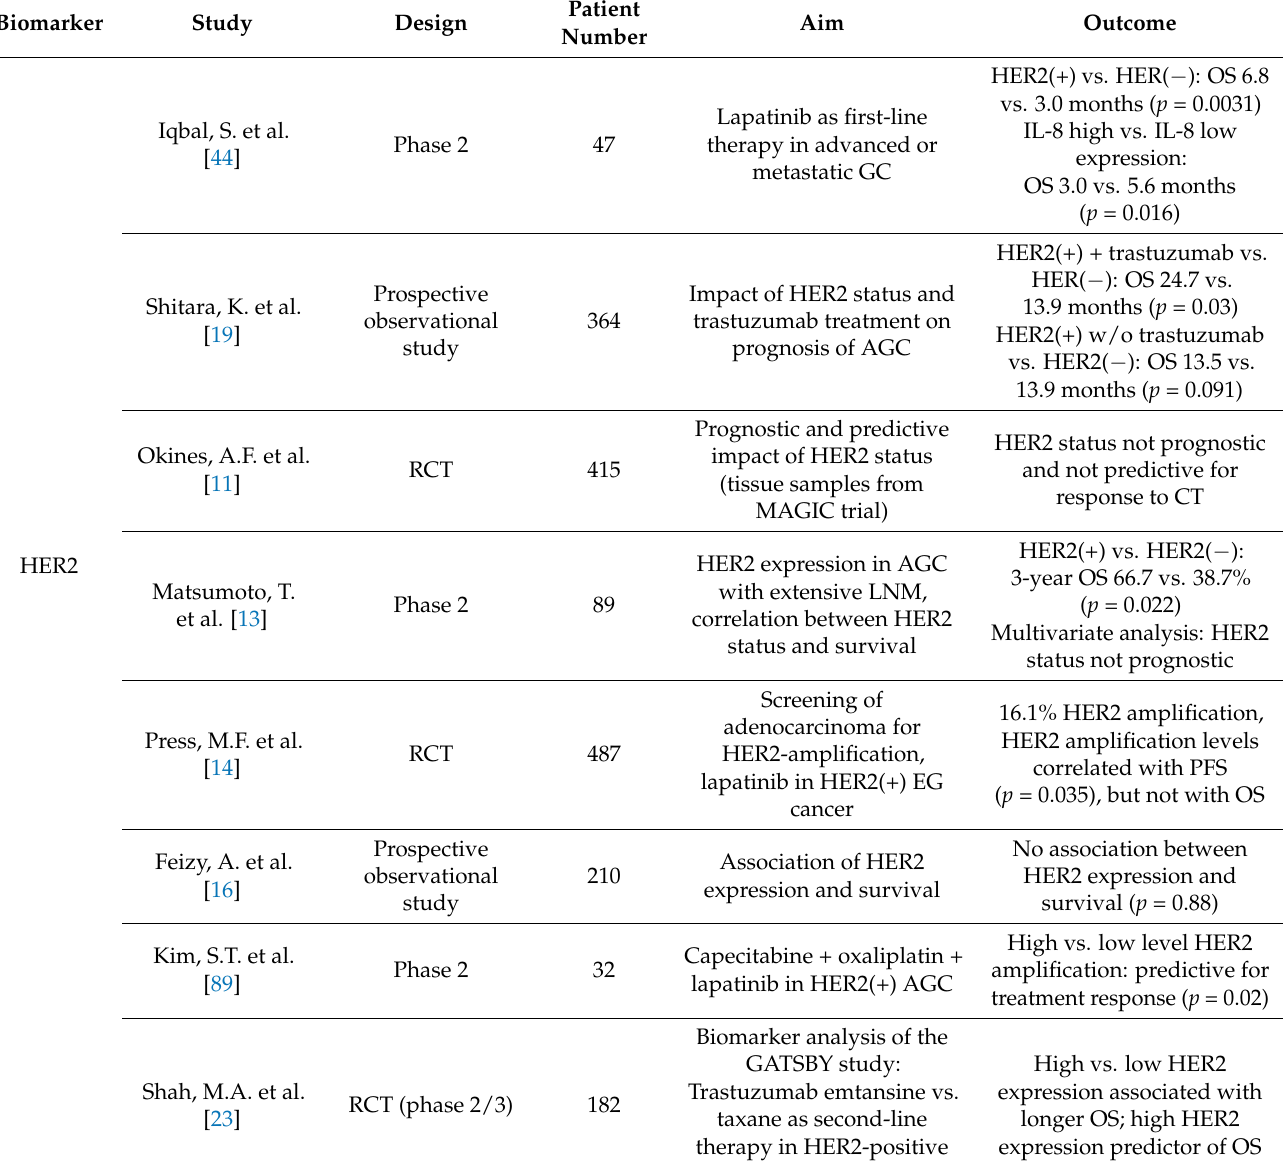
Table 2. Biomarkers and their impacts on